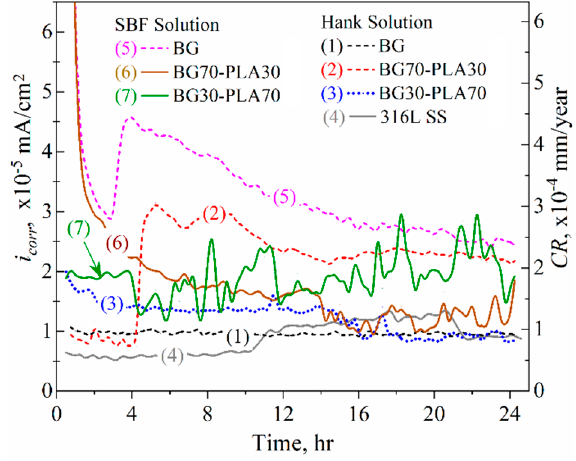
Figure 16. i corr kinetics for the BG-PLA coatings in Hank’s and SBF solutions at 37 °C.